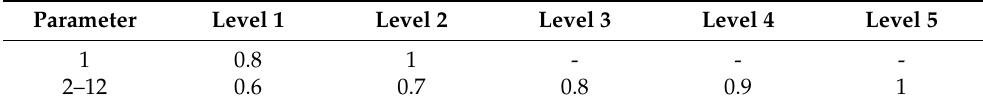
Table 3. Optimization parameters and their